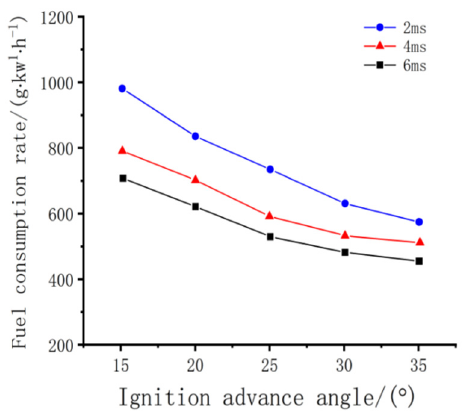
Figure 20. Effect of the ignition parameters on fuel consumption.